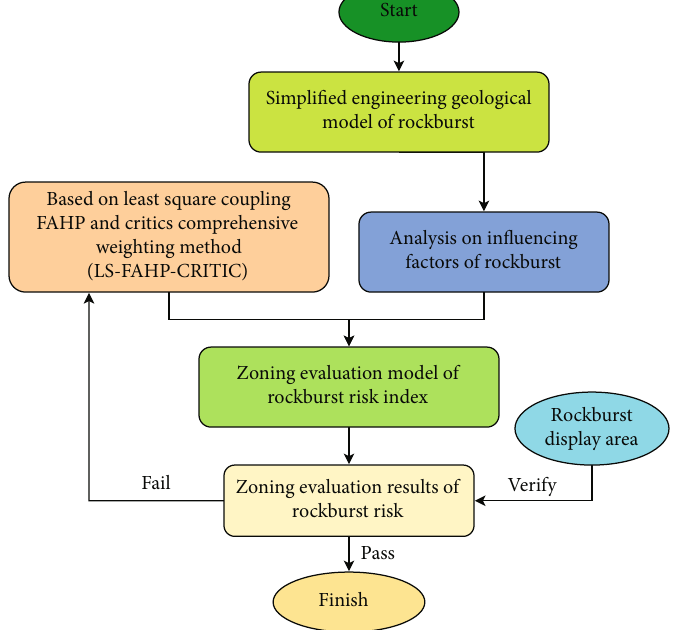
Figure 6: Flowchart of the